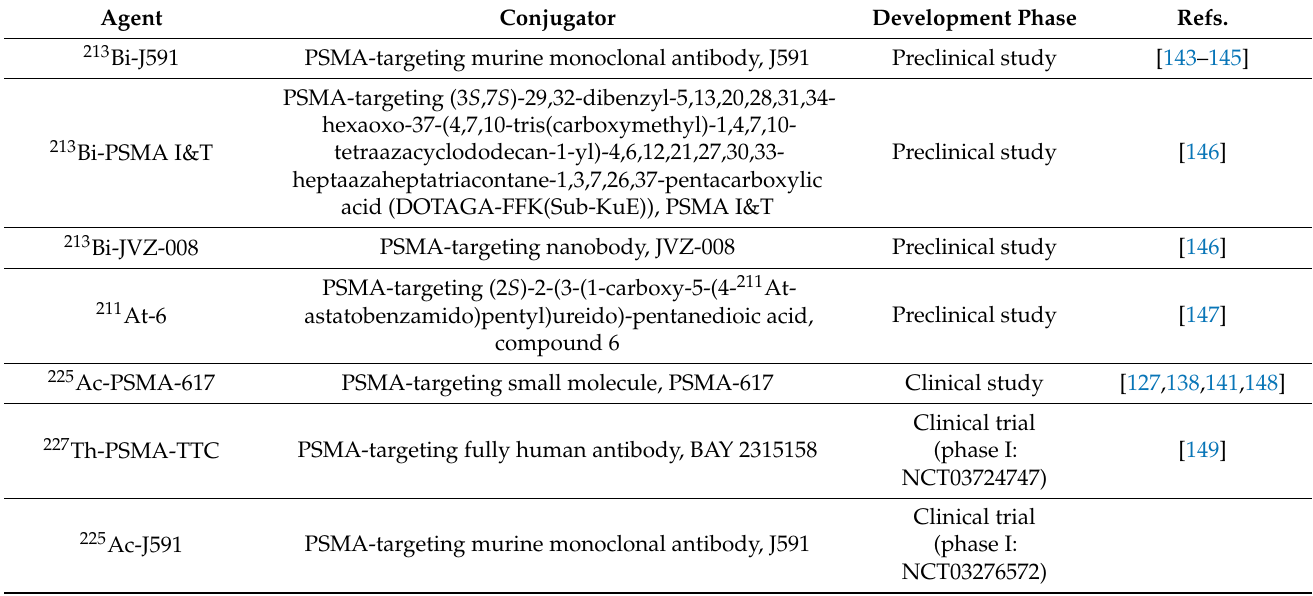
Table 2. The recent status of PSMA-targeted alpha-particle-emitting radiopharmaceuticals. Agent Conjugator Development Phase